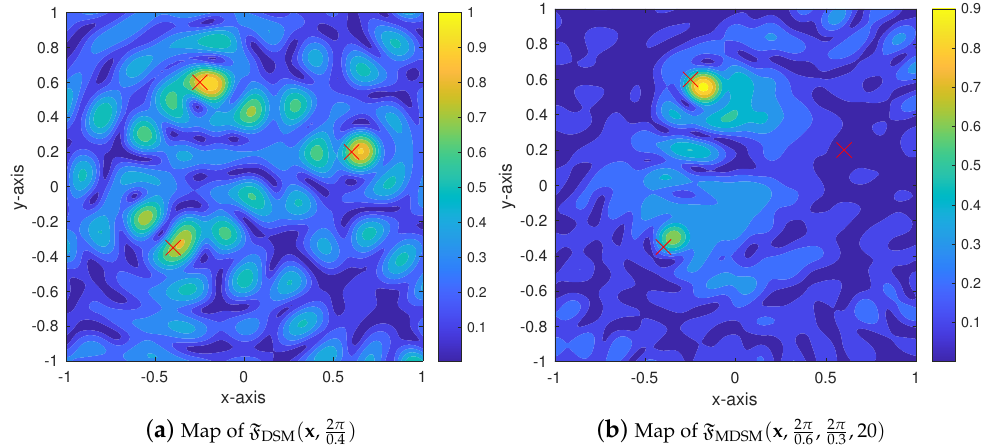
Figure 3. (Example 1) Simulation results with d = ( 1,0 ) . The red-colored marks × denote the locations of cracks.